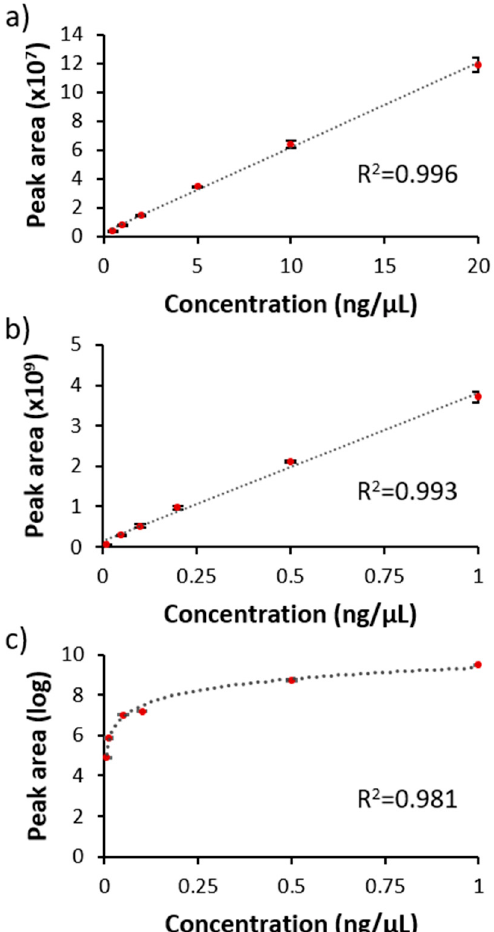
Figure 3. Calibration curves of: ( a ) the unique peptide (LLIYDTSK) of palivizumab; ( b ) the SIS peptide; and ( c ) PEG-28. The error bars represent standard deviations of three measurements.